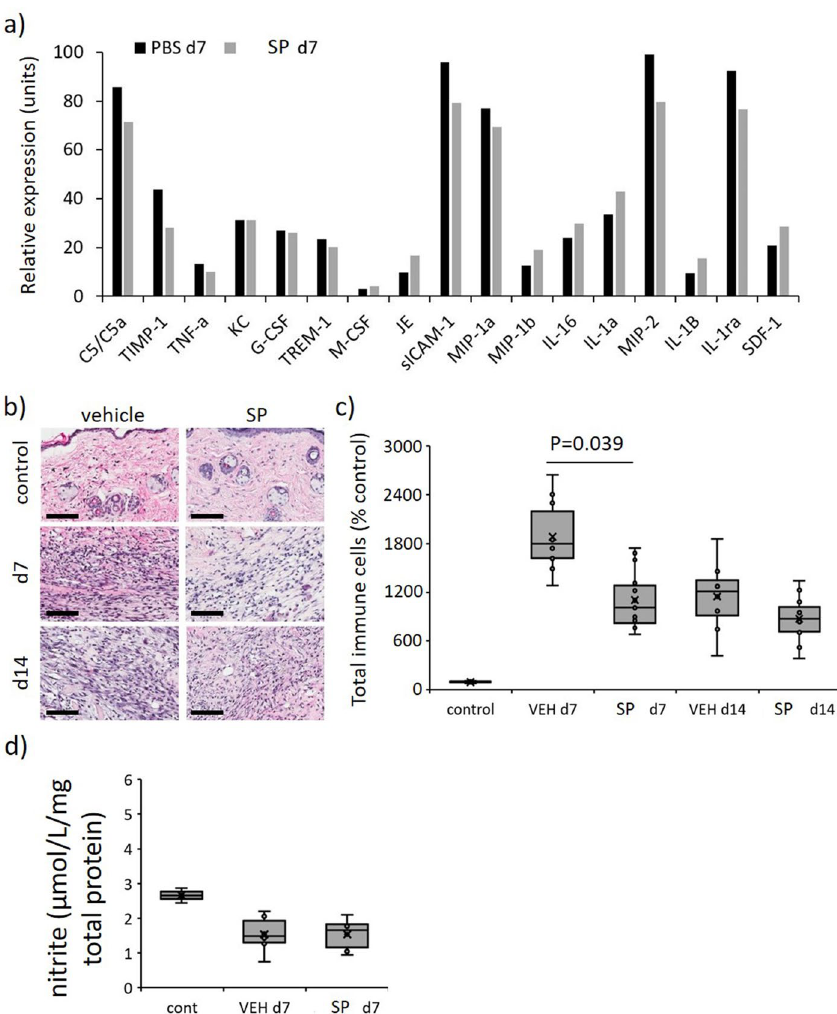
Figure 6. Reduced overall inflammation in SP-treated pressure injury. ( a ) Profiler screening of a panel of cytokines/chemokines in tissue extract from pressure injury at d7 post-initiation of I/R. Data displaying relative expression and expressed as mean pixel intensity, mean of n = 2 per time point per group. Total inflammatory cell infiltrate representative H&E stained tissue section images ( b ) and quantification ( c ) in mouse